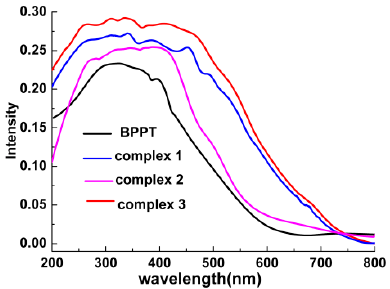
Figure 6. UV/vis spectrogram of 2, 5-bis(3-(pyridine-4-yl)phenyl)thiazolo[5,4-d]thiazole (BPPT) as well as complexes 1 , 2 , and 3 in the solid state.